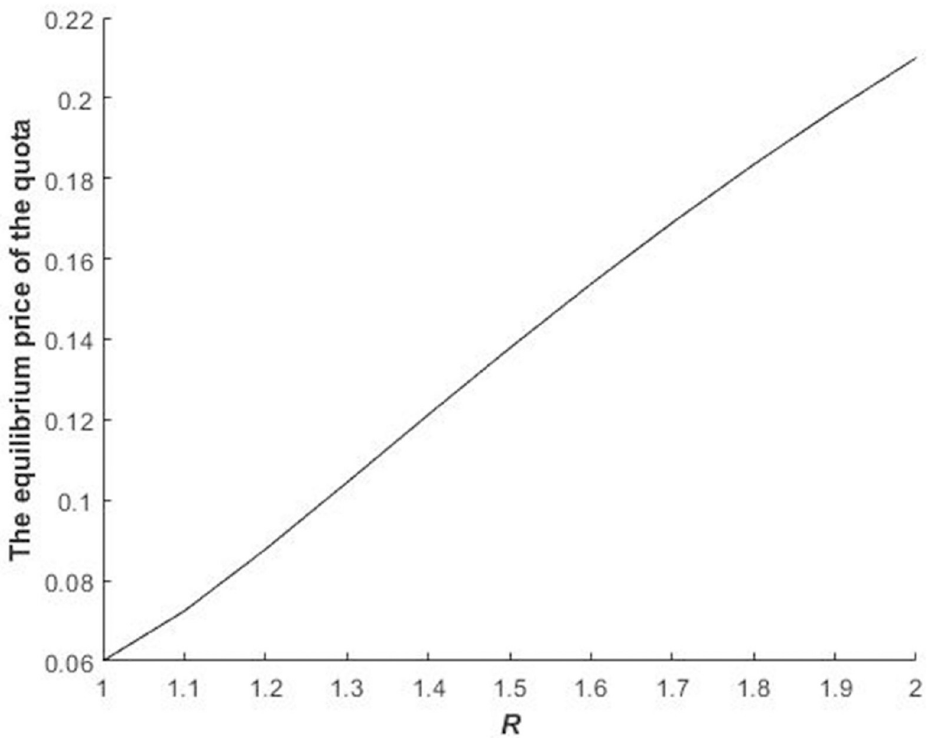
Fig 2. Impact of R on the bidders’ equilibrium bidding price of the quota during the first stage.